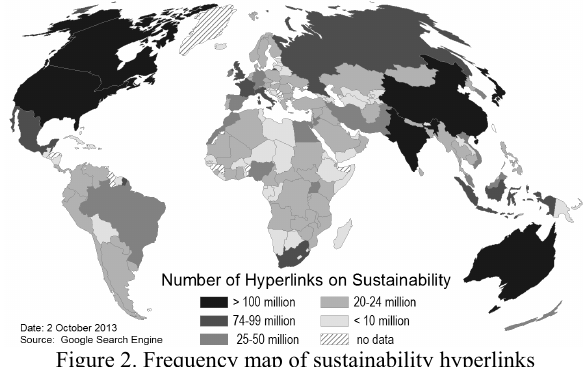
Figure 2. Frequency map of sustainability hyperlinks There are some unexpected results. Belize, the ministate in Central America, and a former British colony, had the